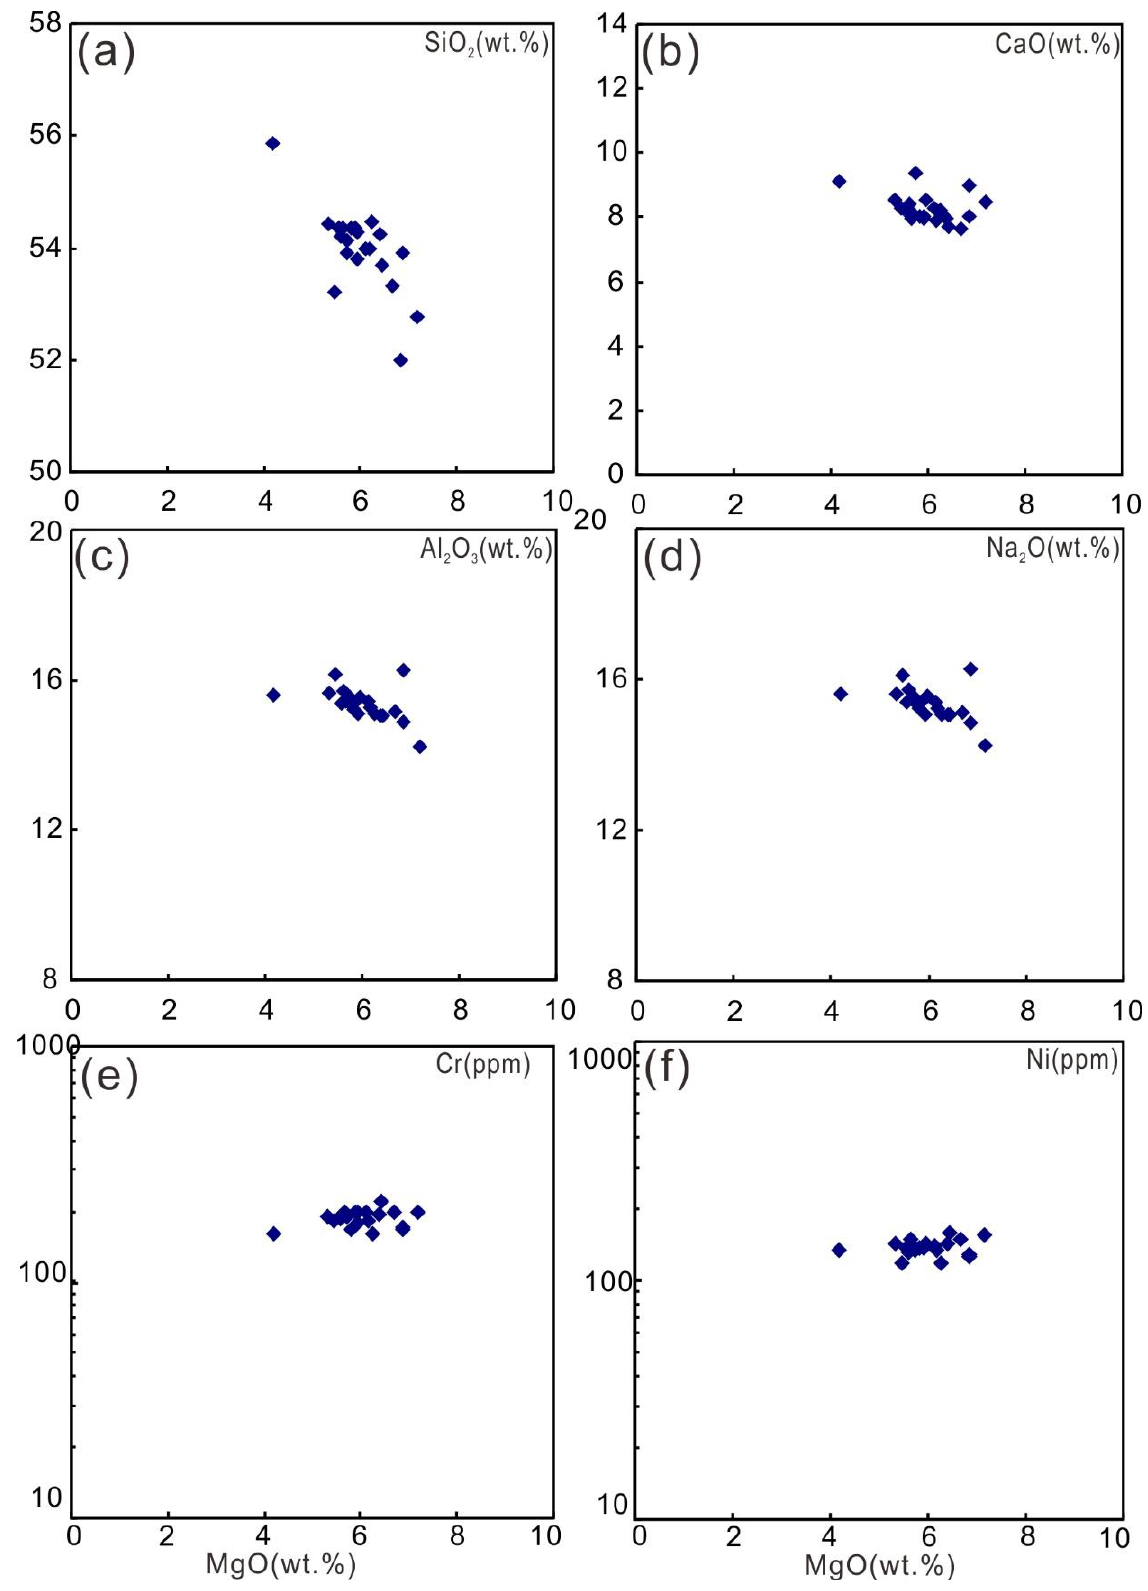
Figure 5. Harker diagrams showing the whole-rock compositional range of volcanic rocks from the Jiangling Basin. ( a ) contents of SiO 2 . ( b ) contents of CaO. ( c ) contents of Al 2 O 3 . ( d ) contents of Na 2 O. ( e ) contents of Cr. ( f ) contents of Ni.